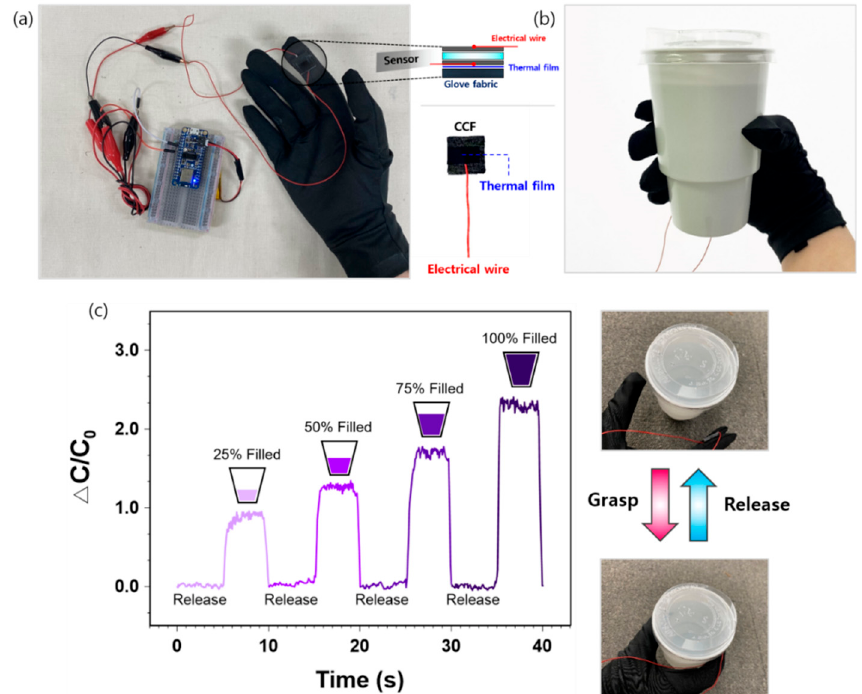
Figure 8. ( a ) Prototype of the finger-grasping-monitoring glove; ( b ) water-cup grasping with the smart glove; ( c ) capacitance variations of grasping motions with a 25%, 50%, 75%, and 100% filled water cup.